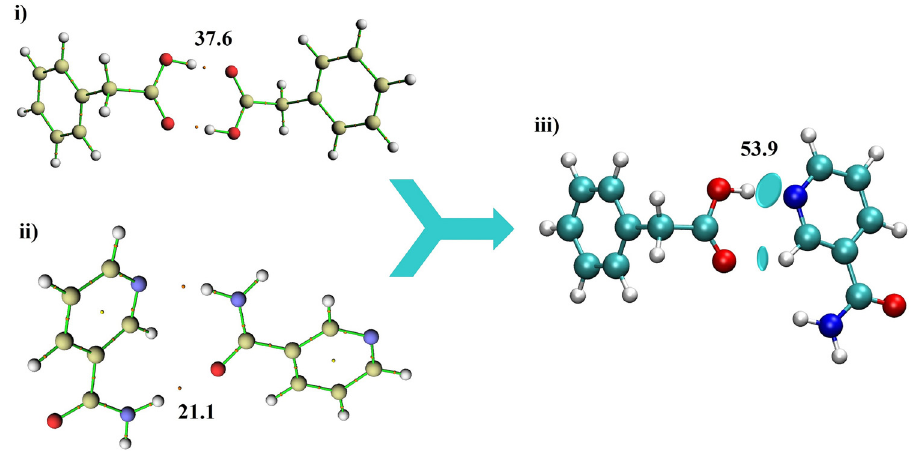
Figure 4: Intermolecular interaction pro fi le based on QTAIM: ( i ) homomolecular PYC; ( ii ) homomolecular NIC, and ( iii ) cocrystal PYCNIC. The written value is EiHB in kJ mol − 1